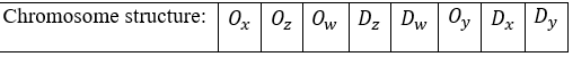
Figure 1. The structure of genes including origins and destinations of passengers